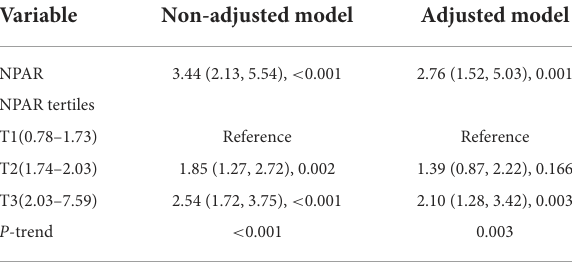
reperfusiontherapymethod. NIHSS, National Institutes of Health Stroke Scale; TOAST, the Trial of Org 10172 in AcuteStrokeTreatment.